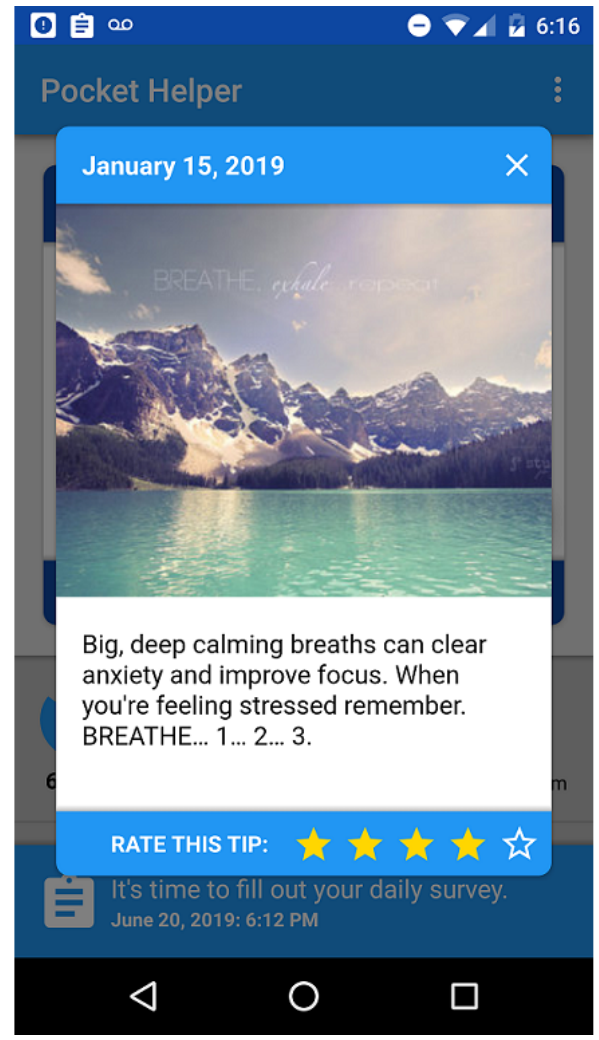
Figure 1. Example of a daily tip in the Pocket Helper 2.0